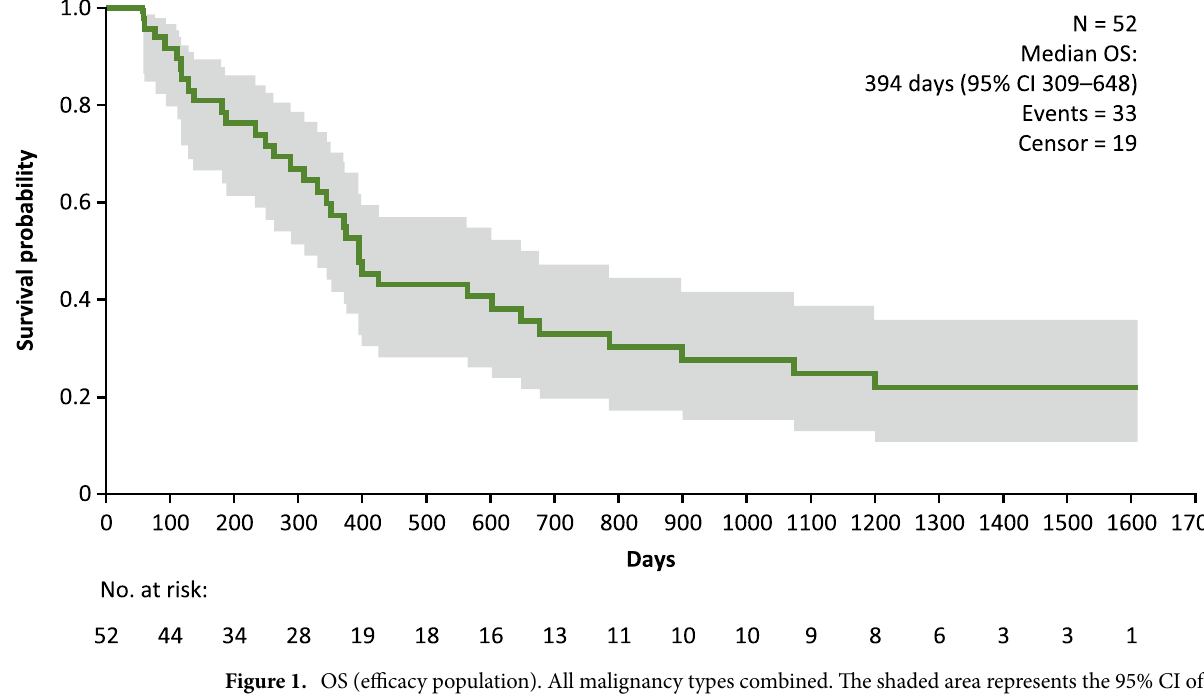
Figure 1. OS (efficacy population). All malignancy types combined. The shaded area represents the 95% CI of the survival probability at that day. CI confidence interval, OS overall